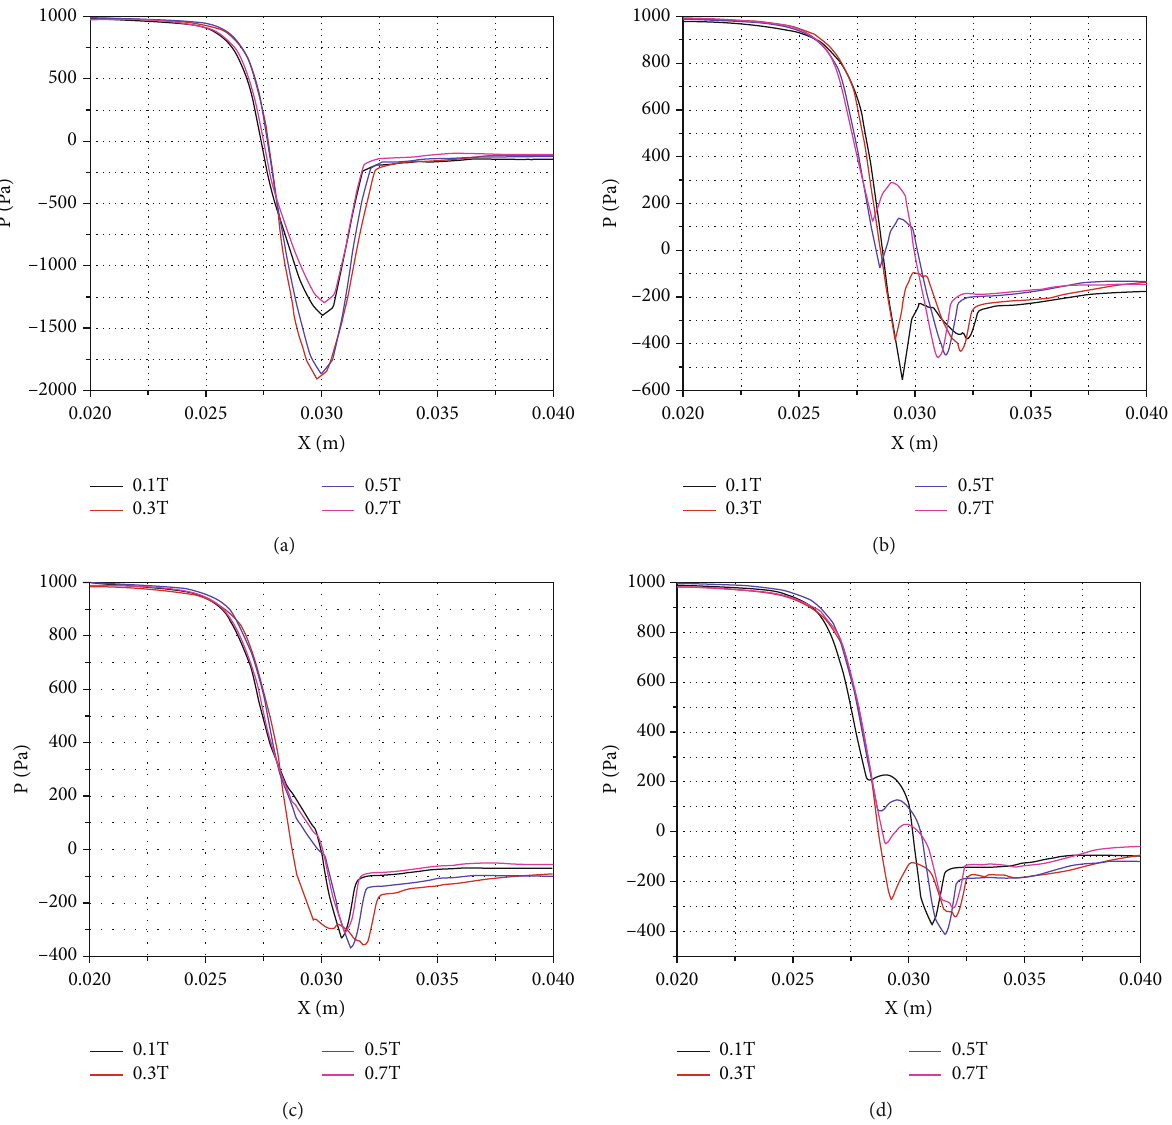
Figure 7: Glottal pressure distribution at di ff erent time-instant of one cycle. (a) 0 mm. (b) 1 mm. (c) 2 mm. (d) 3